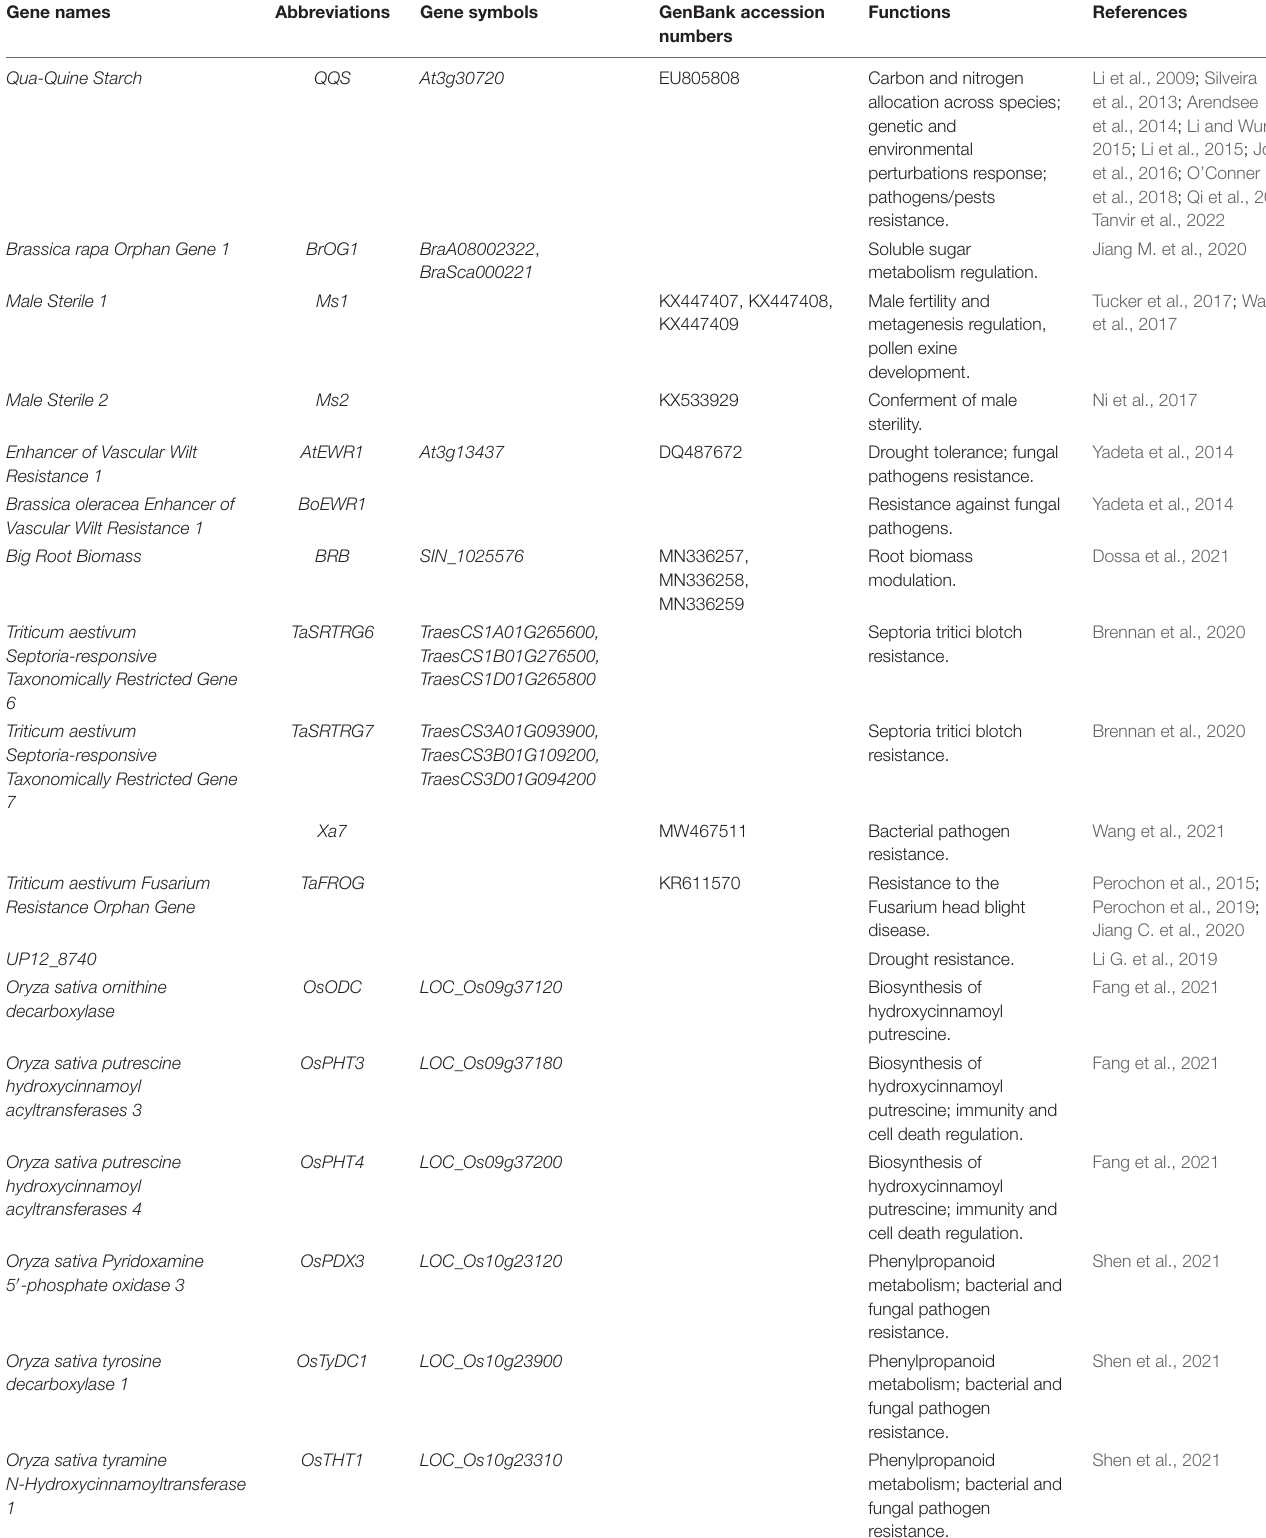
TABLE 2 | Summary of functional analysis of orphan genes ( OGs ) in